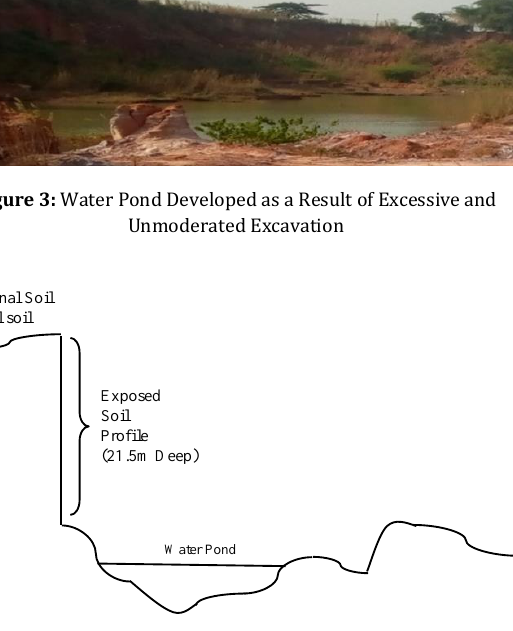
Figure 4: Schematic Diagram Depicting the Configuration of the Study Area